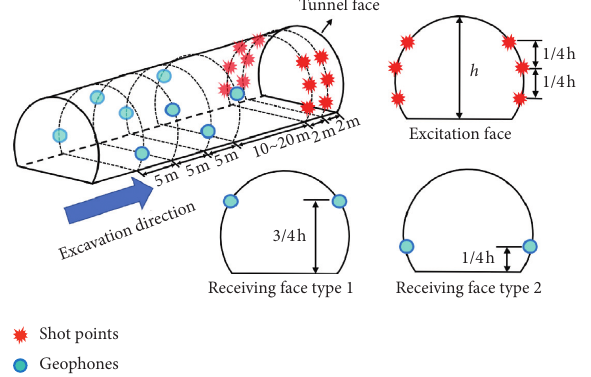
Figure 3: Schematic of instrument arrangement and observation system for seismic